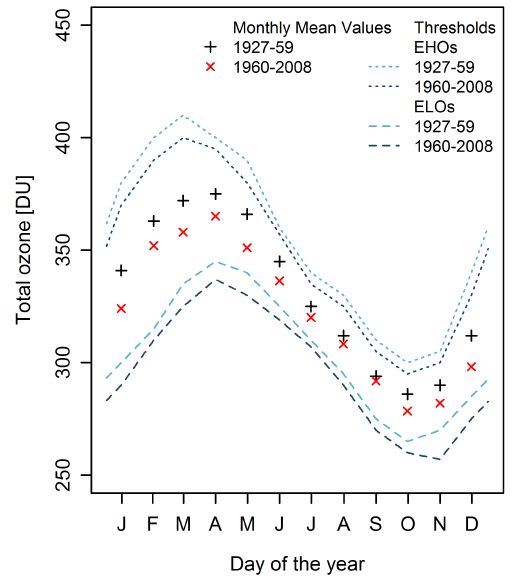
Fig. 9. Density plots of (a) annual total ozone observations at Arosa for the time periods 1927–1959 and 1960–2008, (b) ozone obser- vations for March in the periods 1927–1959 and 1960–2008, (c) annual total ozone observations with extremes removed for the time periods 1927–1959 and 1960–2008 and (d) ozone observations with extremes removed for March in the periods 1927–1959 and 1960– 2008. Mean values for the time periods are given as vertical